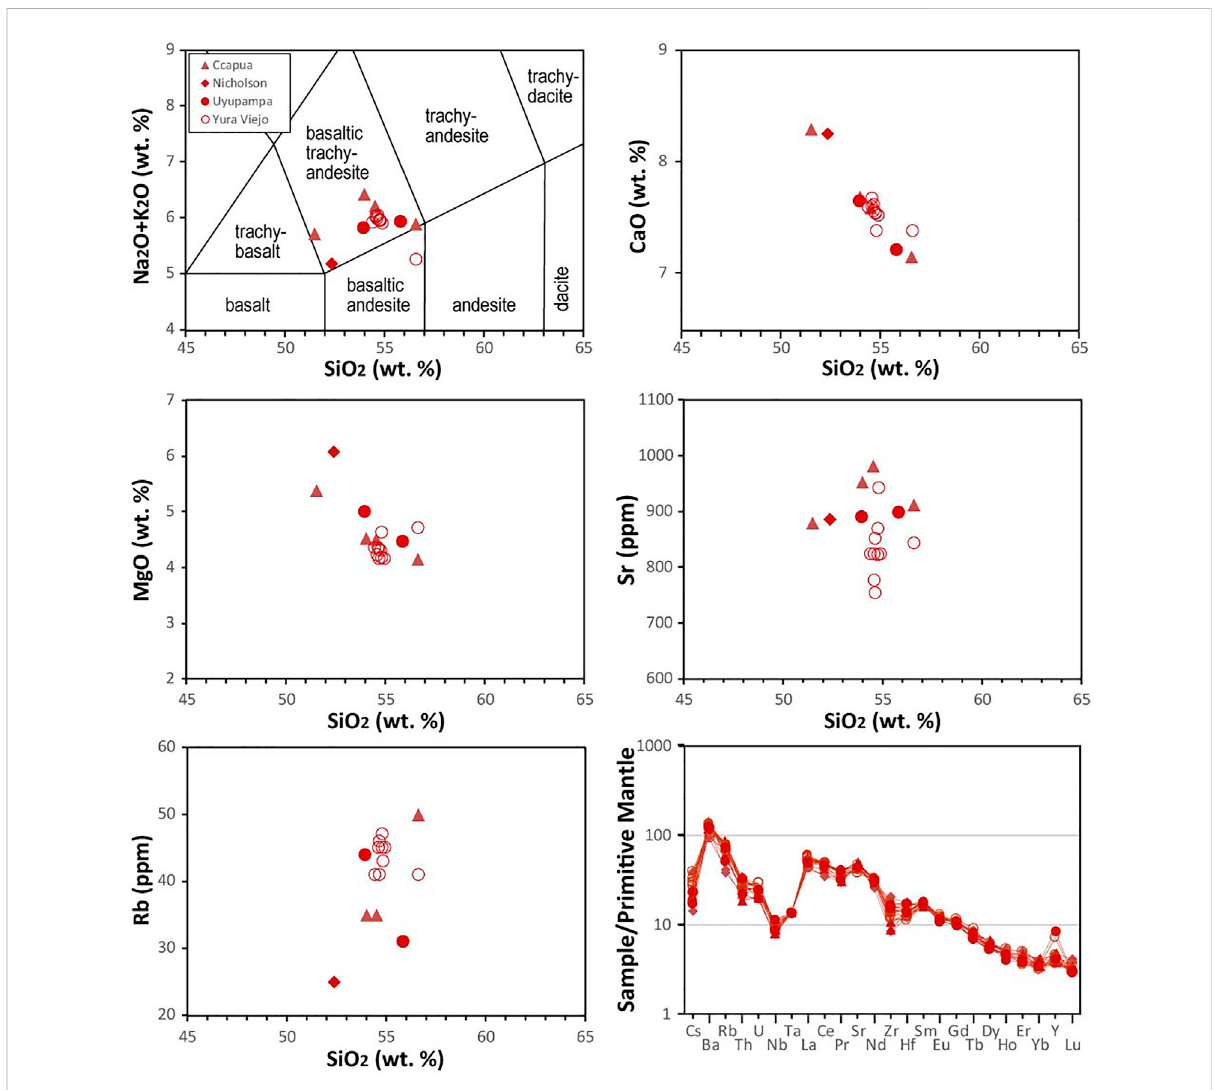
FIGURE 10 Chemical compositionofYura monogenetic volcanoes. Total Alkali-SilicaversusSiO 2 diagram(LeBas etal., 1986)showing theclassi fi cation of Nicholson, Ccapua, Yura Viejo and Uyupampa volcanoes. Major oxides are shown as recalculated volatile-free values. Ca, MgO, Sr, and Rb versus